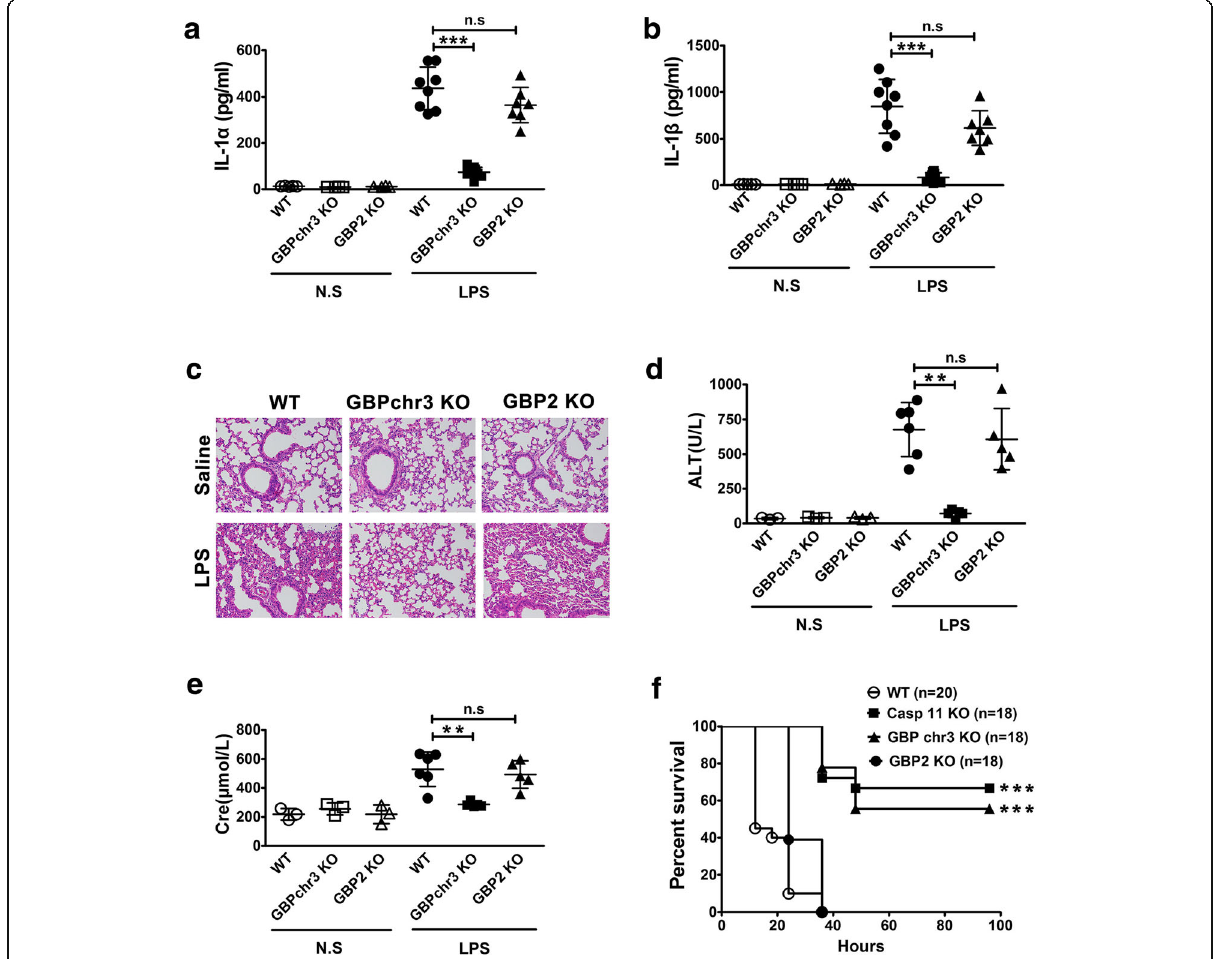
Fig. 5 GBPs are essential for caspase-11-dependent immune responses and lethality in endotoxemia. a-b Serum IL-1 α and IL-1 β levels from mice of indicated genotypes following intraperitoneal injection with either 10 mg/kg LPS or saline. c H&E staining of the lungs from mice of indicated genotypes ( n = 5) following intraperitoneal injection with either 10 mg/kg LPS or saline. d-e The serum alanine aminotransferase (ALT) and creatinine (Cre) levels from mice of indicated genotypes following intraperitoneal injection with either 10 mg/kg LPS or saline. f Kaplan Meier survival curves for the indicated genotypes following intraperitoneal injection with 40 mg/kg LPS . * P <0.05; ** P <0.01; *** P <0.001 (Student ’ s t-test and log-rank test for survival). Graphs show the mean ± SD. Data are representative of at least three independent